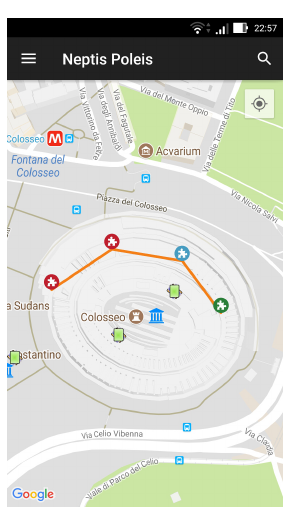
Figure 1. NEPTIS Poleis homepage